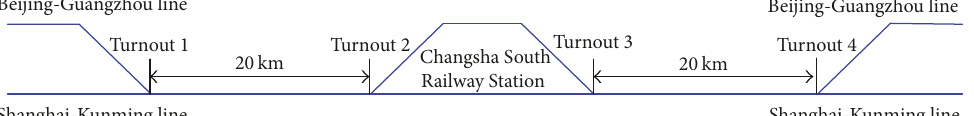
Figure 7: Changsha South Station